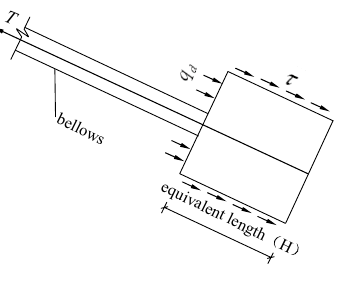
Figure 2. The force diagram of the anchor-pulling system in the phase of earth pressure at